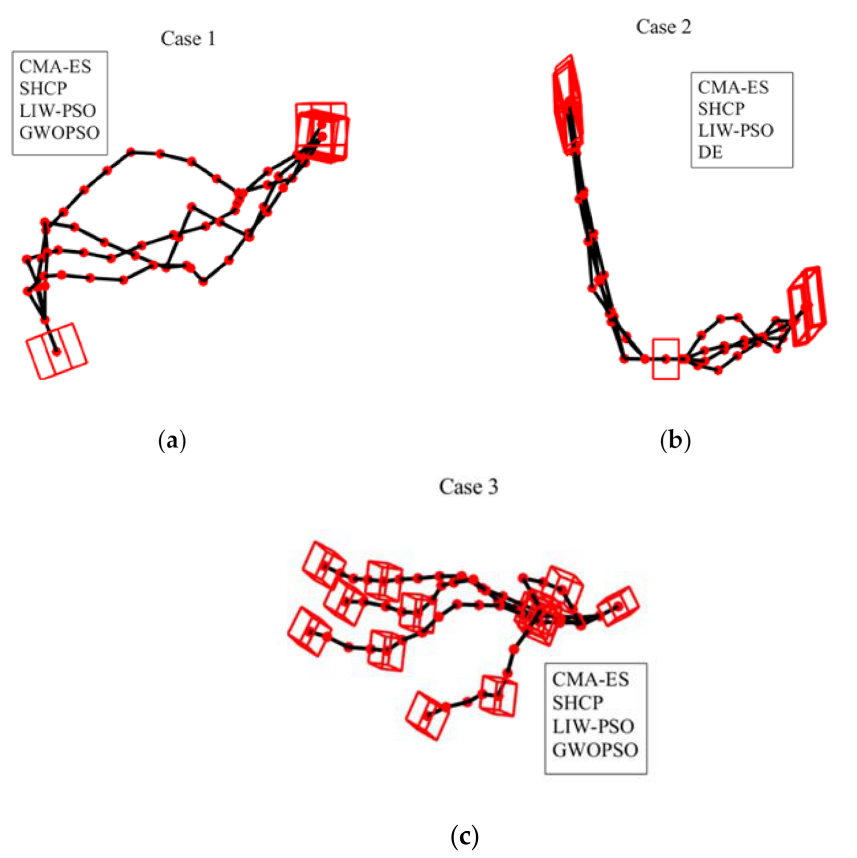
Figure 7. The configurations obtained by different algorithms of SMSRS for three cases. ( a ) Case 1; ( b ) Case 2; ( c ) Case 3.